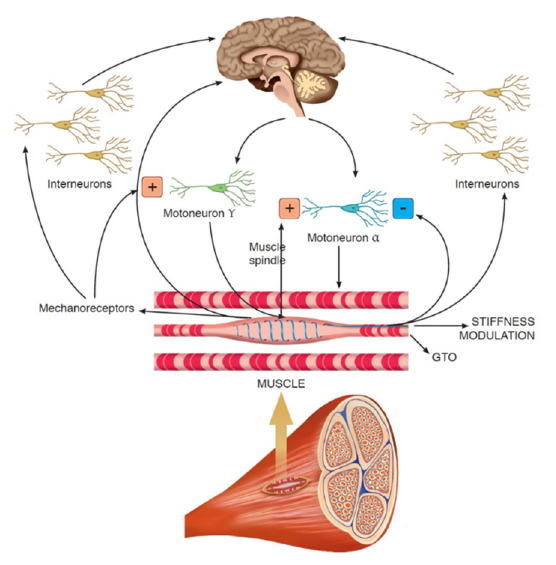
Figure 1. The role of whole-body vibration on neuromuscular fuses. Moreover, WBV has been recently proposed to improve bone turnover and functional outcomes in cancer patients, with controversial findings